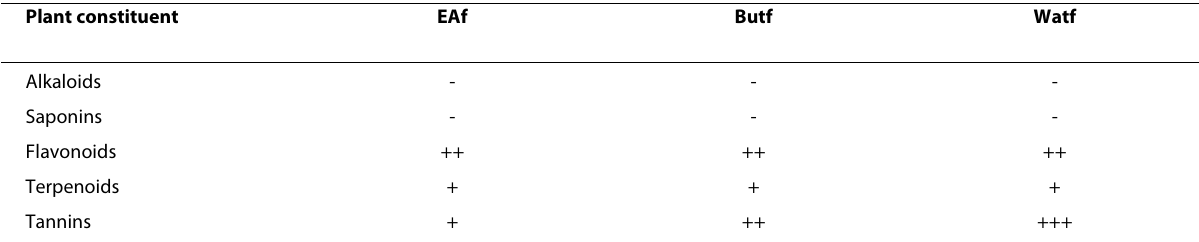
Table 5: Phytochemical analysis of Blechnum orientale active fractions Plant constituent EAf Butf Watf Alkaloids - Saponins